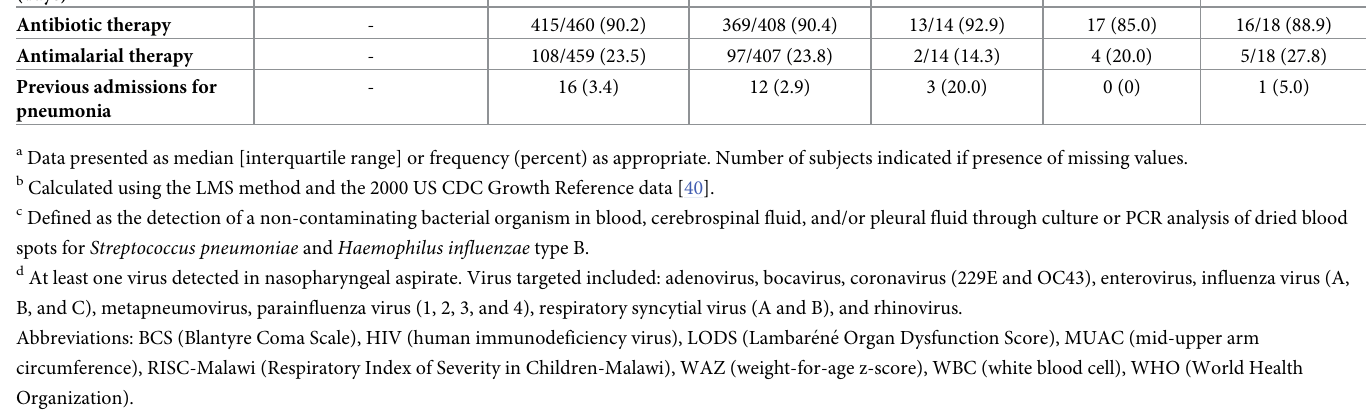
to 0.839) to 0.812 (95% CI: 0.716 to 0.908) (Fig 2C, S3 Table). Best two-biomarker combination for 28-day mortality was IL-8 and sFlt-1 (AUROC: 0.847 [95% CI: 0.770 to 0.924]), while for 90-day mortality was IL-8 and sTREM-1 (AUROC: 0.828 [95% CI: 0.742 to 0.914]). However, two-biomarker models did not outperform models with only IL-8 (p � 0.05). The sensitivity analysis evaluating secondary outcomes only for children not dying during initial hospital admission showed similar results. Best AUROCs for 28-day mortality also were from sFlt-1 (0.744 [95% CI: 0.523 to 0.965]), sTREM-1 (0.686 [95% CI: 0.447 to 0.925]),